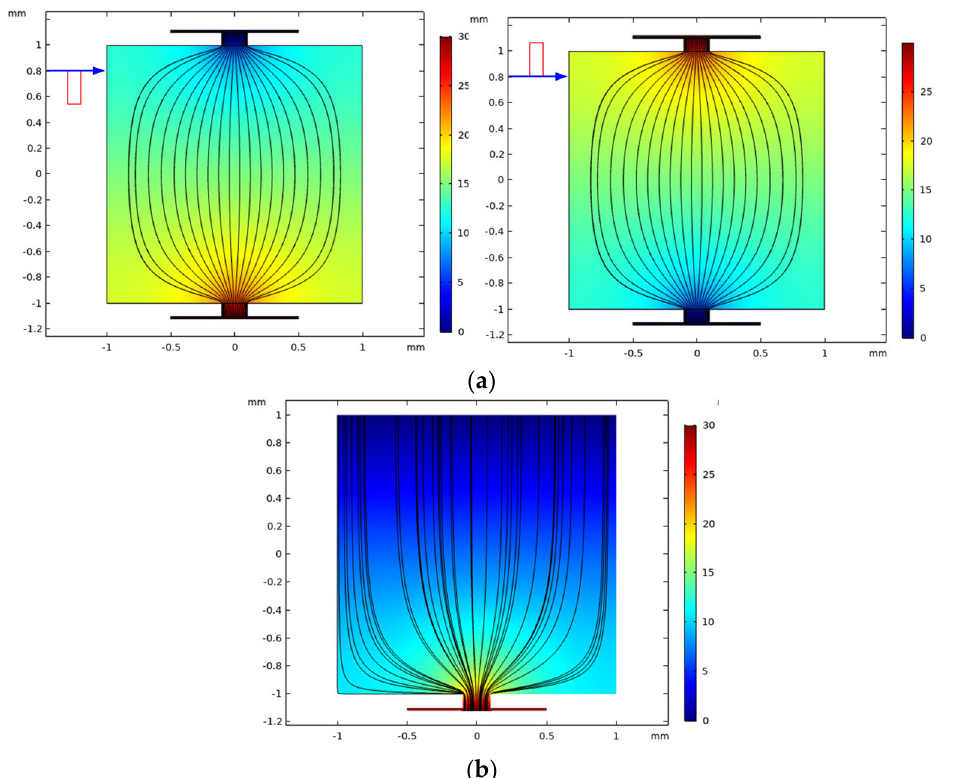
Figure 4. The electric line distribution with different machining modes. ( a ) bidirectional pulse; ( b ) unidirectional pulse.